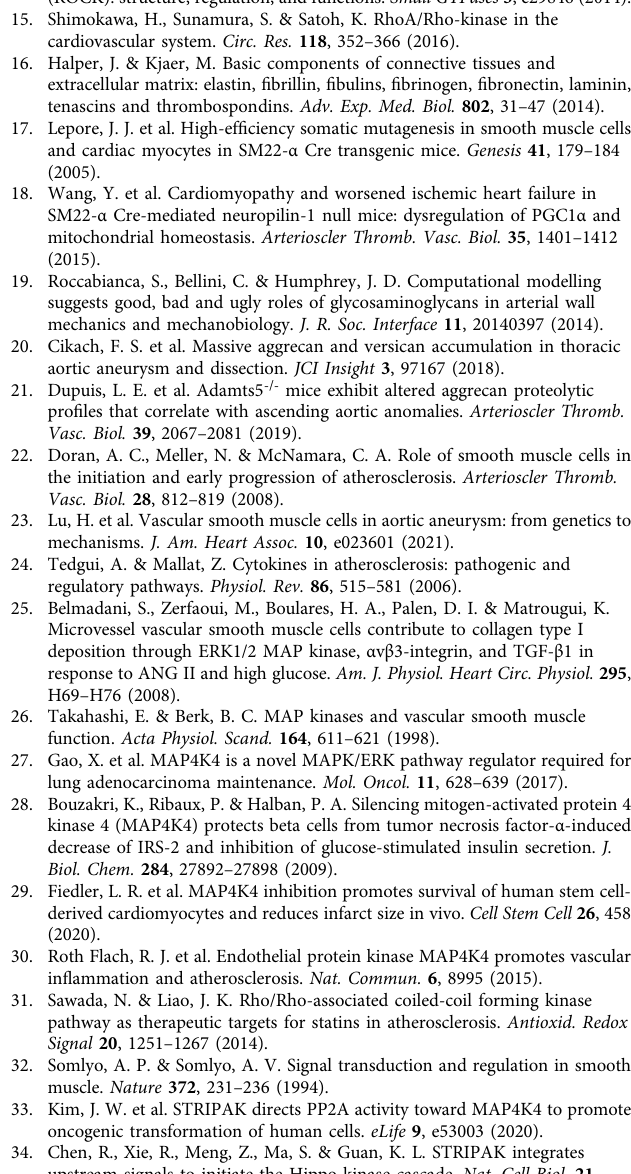
Fig. 7 Identi fi cation of the molecule that mediates the signaling between RhoA and MAP4K4. a After transfection of GFP or GFP-RhoA-WT expression plasmid, VSMCs were stimulated with AngII for 24h. The cell extracts were immunoprecipitated and immunoblotted with the anti-GFP antibody (upper panel), and the immunoprecipitated proteins to the anti-GFP antibody were detected by Coomassie Brilliant Blue (CBB) staining (lower panel). Single star and double stars: IgG heavy and light chains, respectively. Arrows: transfected GFP or GFP-RhoA-WT. Bands surrounded by red dotted rectangles were further analyzed by LC-MS/MS. b Western blotting for P-MAP4K4 and MAP4K4 in aortic RhoA cKO VSMCs transfected with scramble or siSet siRNA. c Summary graph of the P-MAP4K4/MAP4K4 ratio. d Cell extracts from control VSMCs after saline or AngII treatment were used in pull-down assays with GST fusion protein including the GTP-bound RhoA-binding domain of mDia, followed by western blotting with anti-Set or anti-RhoA antibody. e After stimulation of control or RhoA cKO VSMCs with AngII for 24 h, cell extracts were immunoprecipitated with anti-PP2A antibody or control IgG, followed by western blotting with the indicated antibodies. f Immuno fl uorescence images of control or RhoA cKO VSMCs stained with the indicated antibodies after treatment with AngII for 24 h. Nuclei were visualized with DAPI. Scale bars: 20 μ m. g , j After transfection of cells with scramble or siSet siRNA and AngII stimulation for 24 h, cell extracts of control or RhoA cKO VSMCs were immunoblotted with the indicated antibodies. h , k Summary graphs of the phosphorylated/total MAP kinase signaling molecule ratios ( h ) and P-MLC2/MLC2, P-MYLK/MYLK, and MYLK/GAPDH ratios ( k ). n = 3 ( h ) and n = 4 – 5 ( k ), each group. i Summary graph of VSMC-containing in vitro collagen gel contractility assay using AngII-stimulated RhoA cKO VSMCs transfected with scramble or siSet siRNA. n = 8, each group. The data were analyzed by t -test ( c ), one-way ANOVA ( h , k ) or two-way ANOVA ( i ) to compare the groups. In ( c ), *** p < 0.001 vs. Scramble; in ( h , k ), ** p < 0.01 and *** p < 0.001 vs. Control, †† p < 0.01 and ††† p < 0.001 vs. Scramble; in ( i ), * p < 0.05 vs.